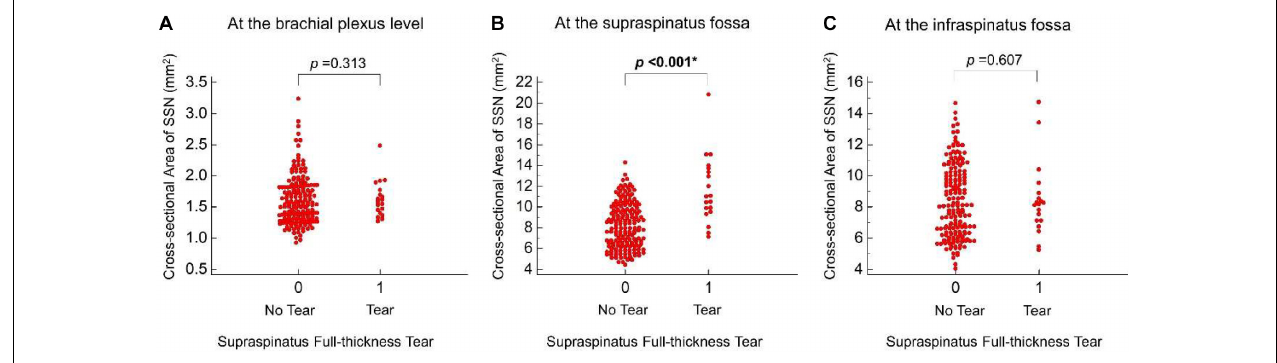
FIGURE 3 | Scatter plots of the cross-sectional area of the suprascapular nerve between shoulders with and without supraspinatus full-thickness tear near the brachial plexus (A) , at the supraspinatus fossa (B) , and at the infraspinatus fossa (C) . P -values pertain to β coefficients of the generalized estimating equation analysis. * Indicates statistical